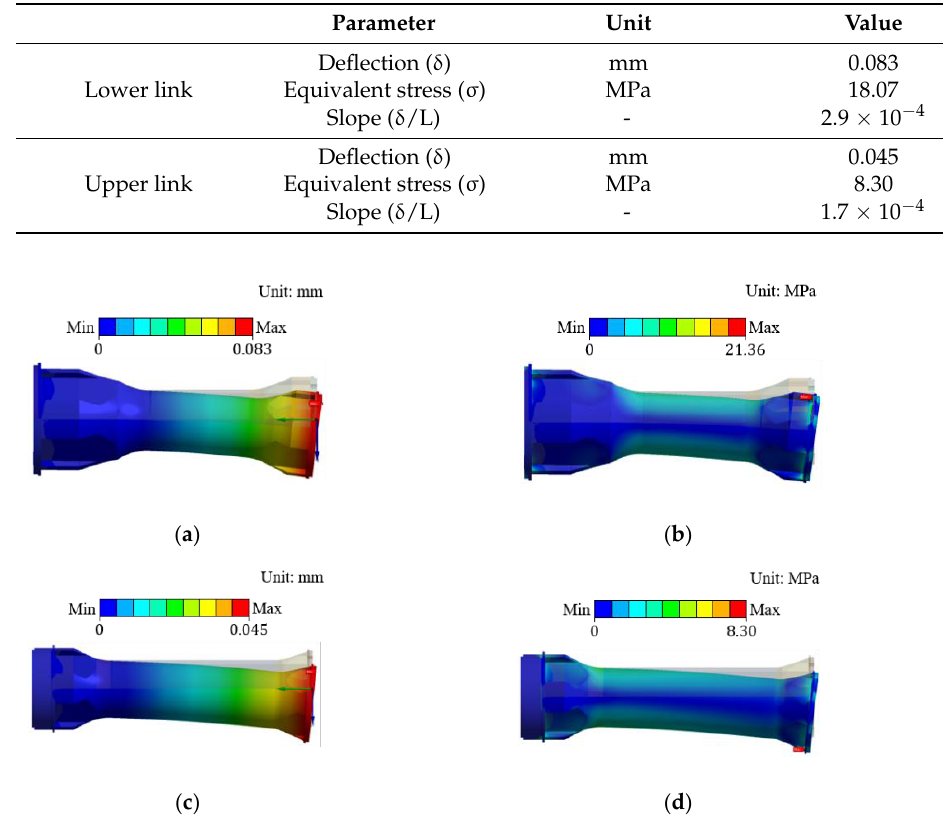
Figure 3. Link stress analysis results: ( a ) Upper link deflection; ( b ) upper link equivalent stress; ( c ) lower link deflection; and ( d ) lower link equivalent stress. Table 2. Results of Links Stress Analysis.